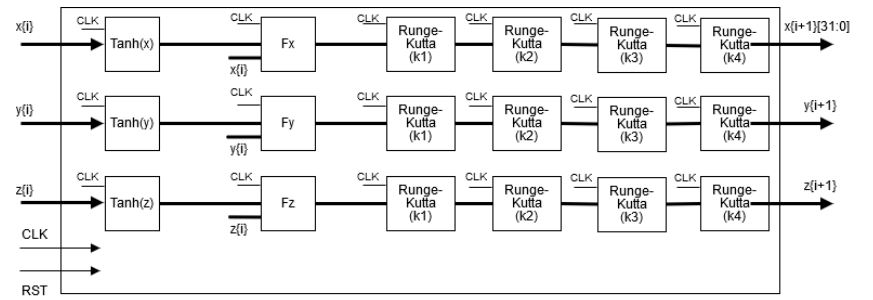
Figure 9. Details of the implementation of the 4th-order Runge–Kutta method solving the Hopfield chaotic neural network, whose block is embedded in Figure 8.